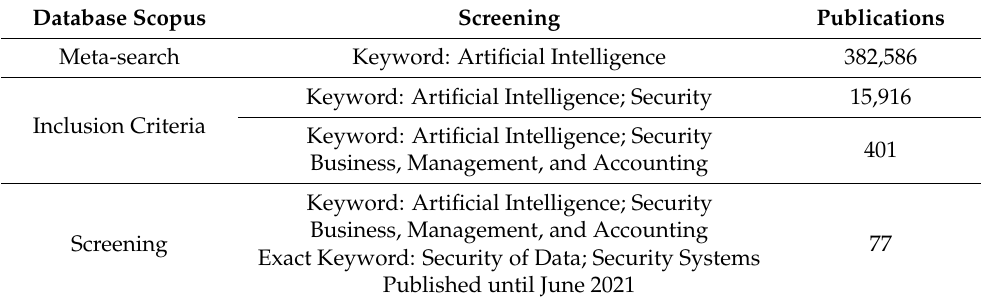
Table 1. Screening